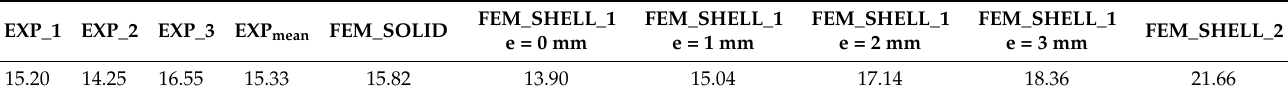
Figure 10. The compression curve (force vs. shortening) of column. Table 1. The maximum reaction forces obtained at ambient temperature in (kN).